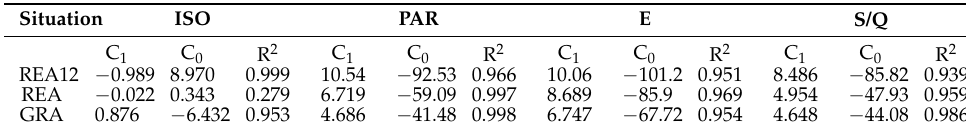
Table 6. The coefficients and R 2 of the fitting lines in responses of O 3 with its driving factors considering isoprene’s role.